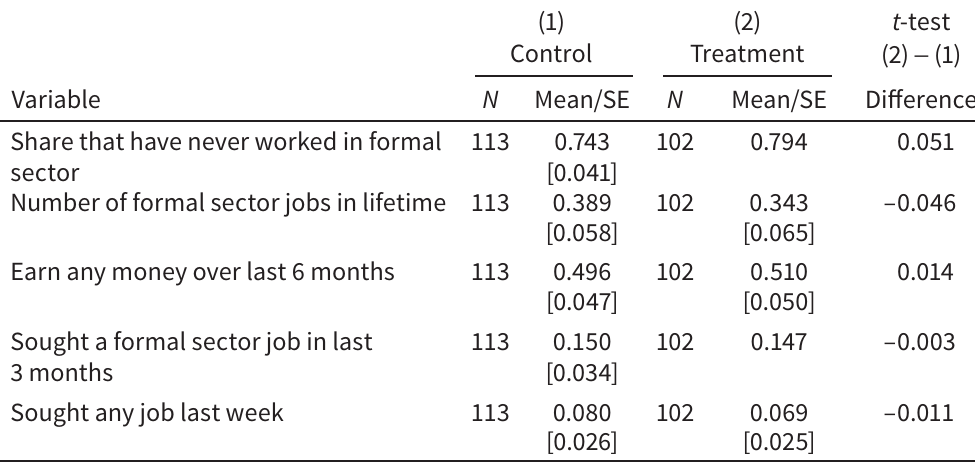
SE, standard errors in